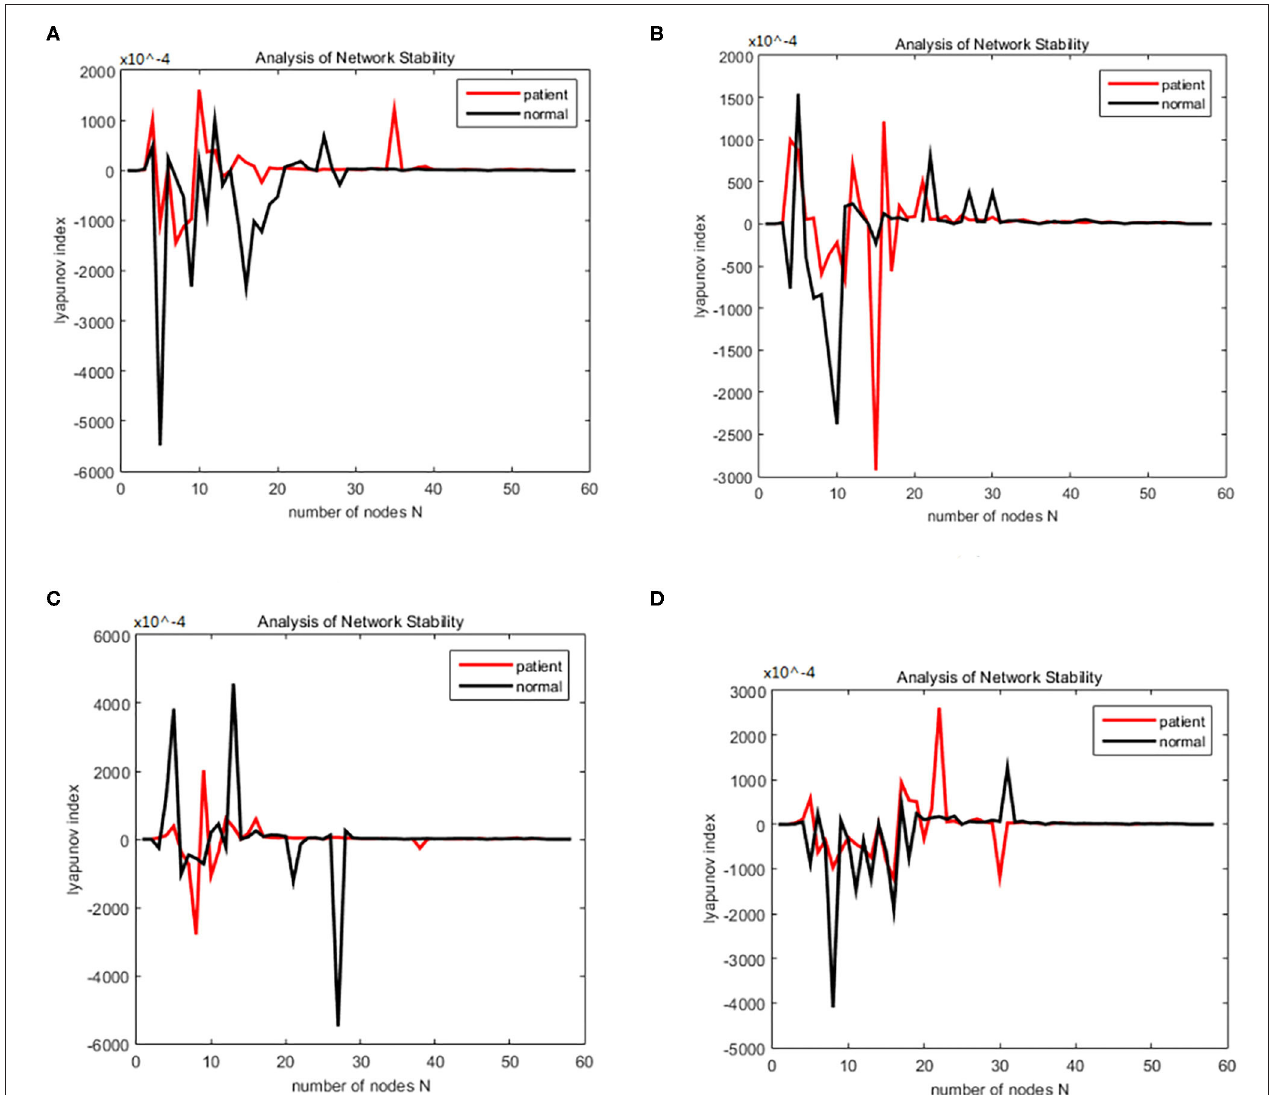
FIGURE 7 | (A–D) Brain network synchronization experimental results for different subjects in the schizophrenia data set under the same connection density (40%).